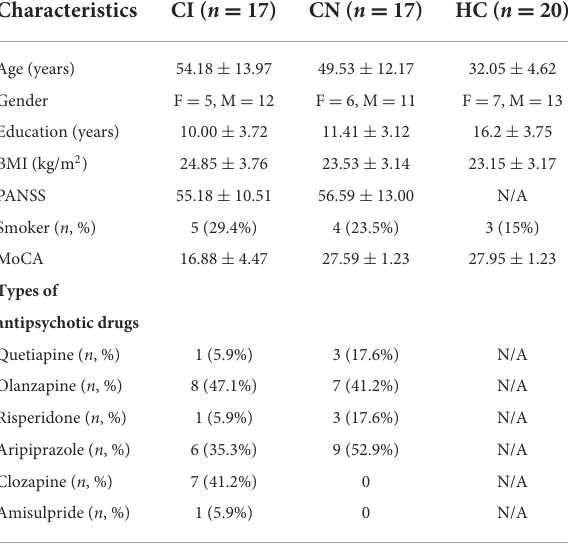
TABLE 1 Demographics and clinical characteristics of